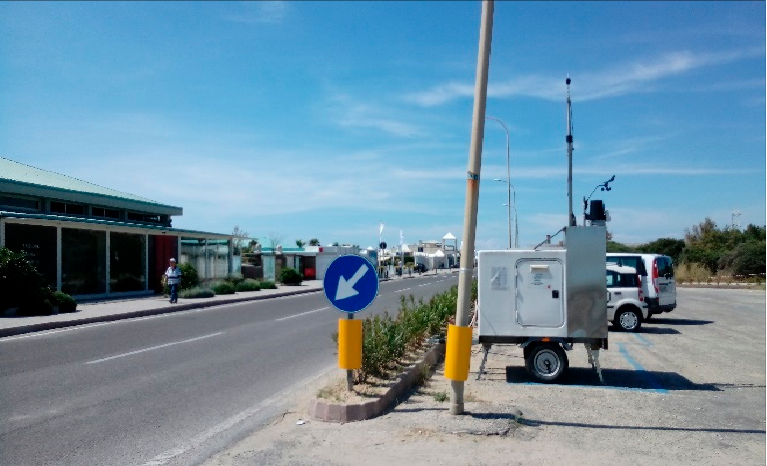
Figure 1. Urban pass-by location in T1 (Marina di Pisa).